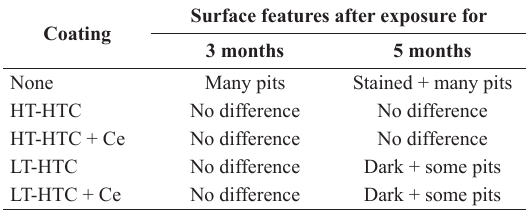
Table 7. Coupon surface features compared to those observed prior to exposure to the IEA-R1 research reactor spent fuel section. Surface features after exposure for Coating